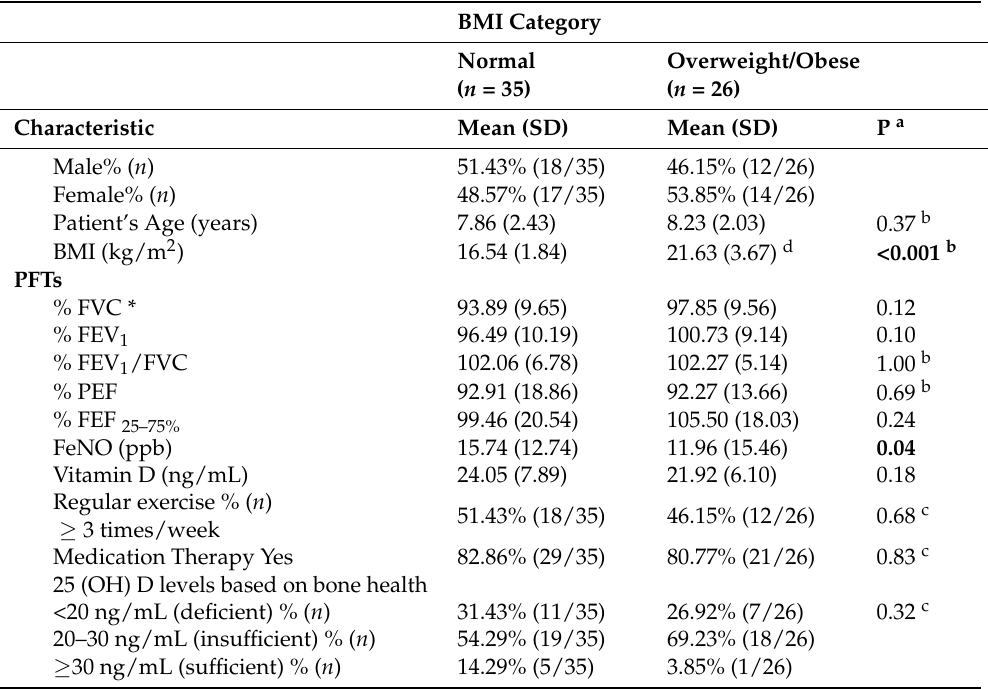
Table 1. Population and clinical characteristics according to BMI